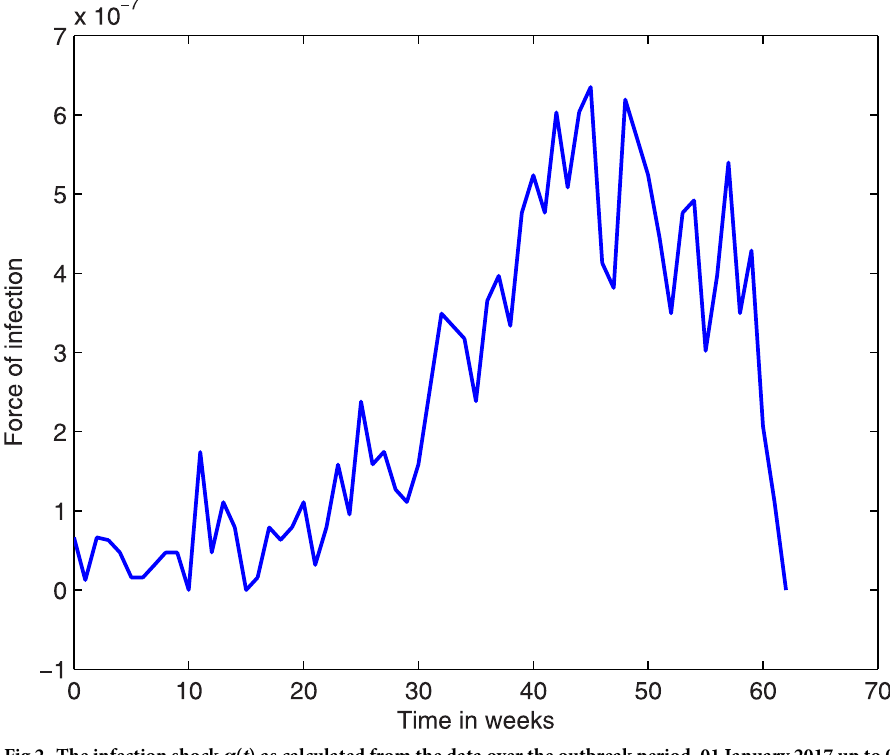
Fig 2. The infection shock α ( t ) as calculated from the data over the outbreak period, 01 January 2017 up to 08 March 2018.